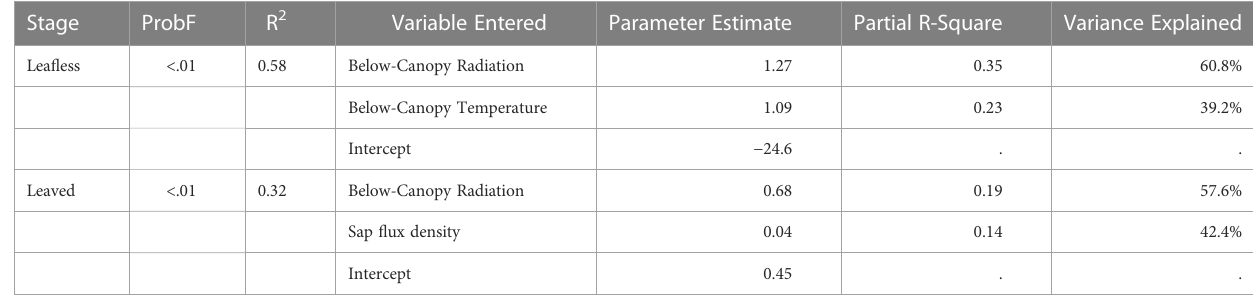
TABLE 4 Stepwise linear multiple regression model predicting E _miss with environmental factors.